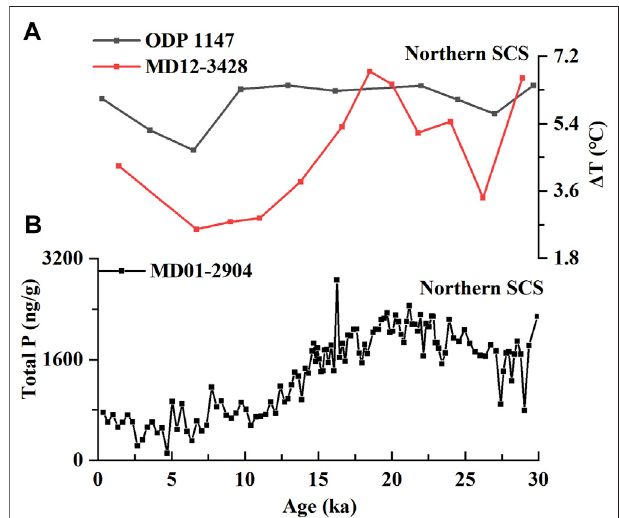
FIGURE 3 | Biogeochemical characteristics of the northern SCS since 30 ka; (A) Δ T of the cores ODP 1147 (Li et al., 2013) and MD12-3428 (Dong et al., 2018) in the northern SCS; and (B) the total productivity of the core MD01-2904 (He et al.,